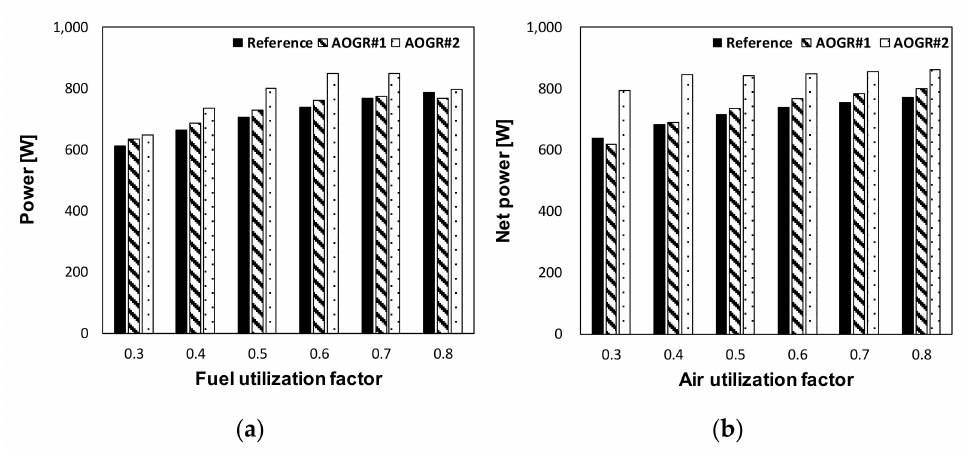
Figure 7. Net power of each configuration with various ( a ) fuel and ( b ) air utilization